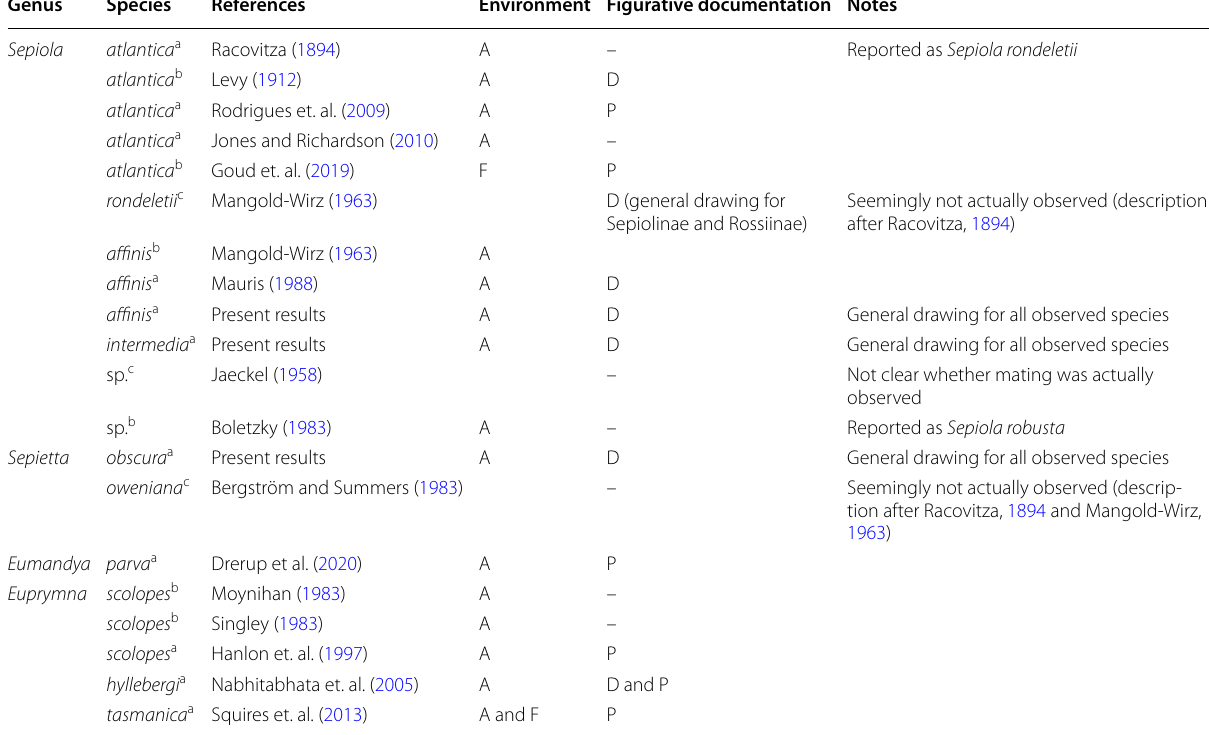
Species: a detailed observations; b partial observations; c questionable. Environment: A